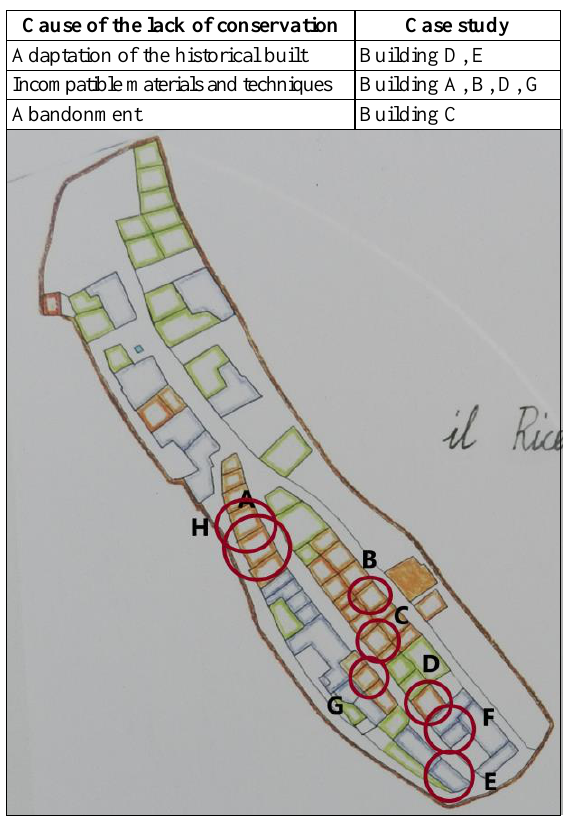
Table 1. Case study